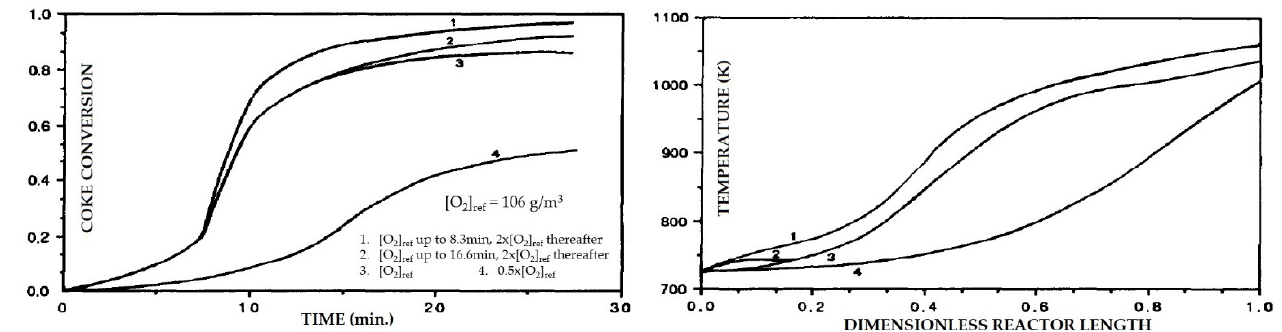
Figure 15. Average coke conversion and temperature profiles in the reactor for different oxygen inlet concentration strategies. Adapted from Santamaria et al. [99].